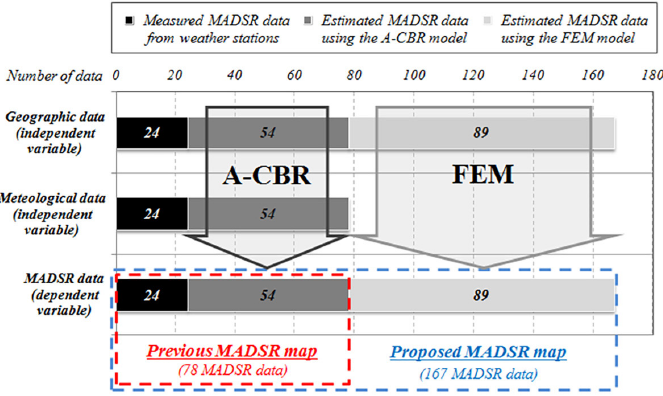
Fig. 2. Data composition